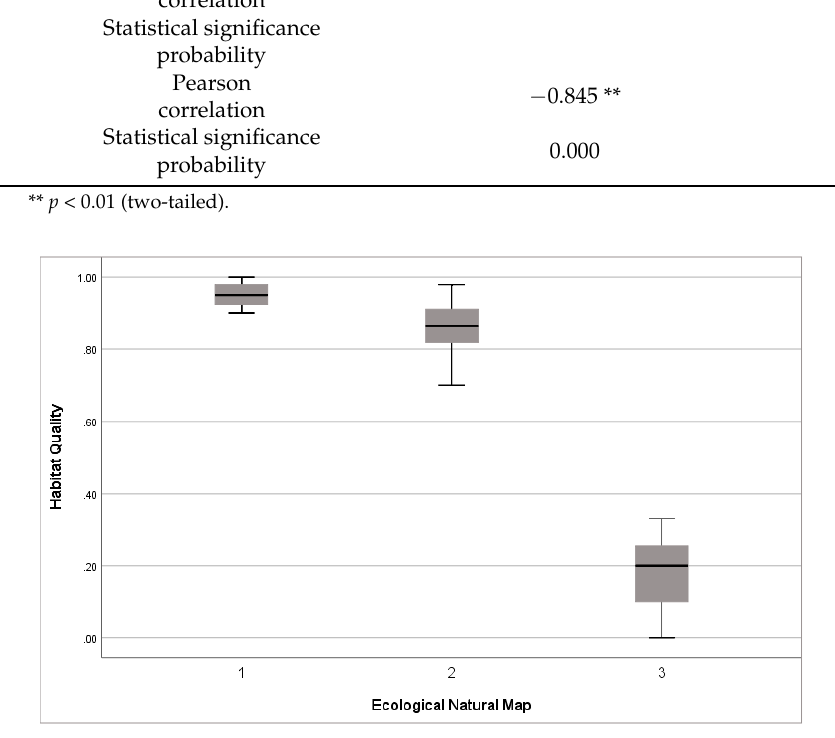
Figure 8. Correlation between the ecological natural maps and habitat quality ( p < 0.01). (Box: 25– 75%; line: median; whiskers: minimum and maximum values).